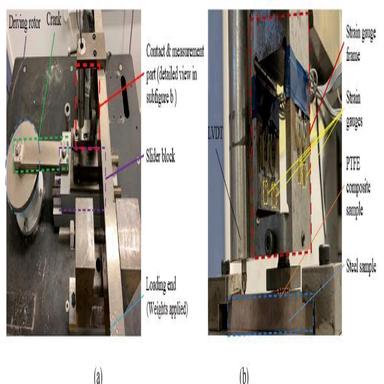
Images of (a) set-up of the reciprocating sliding wear test rig and (b) detailed view of the contact & measurement part.